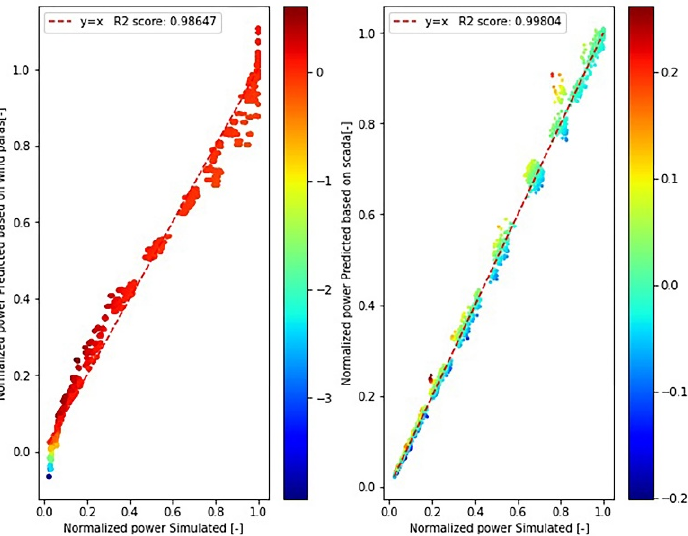
Figure 6. The comparison result of the actual value and the predicted value of wind2power model and SCADA2power model. and SCADA2power